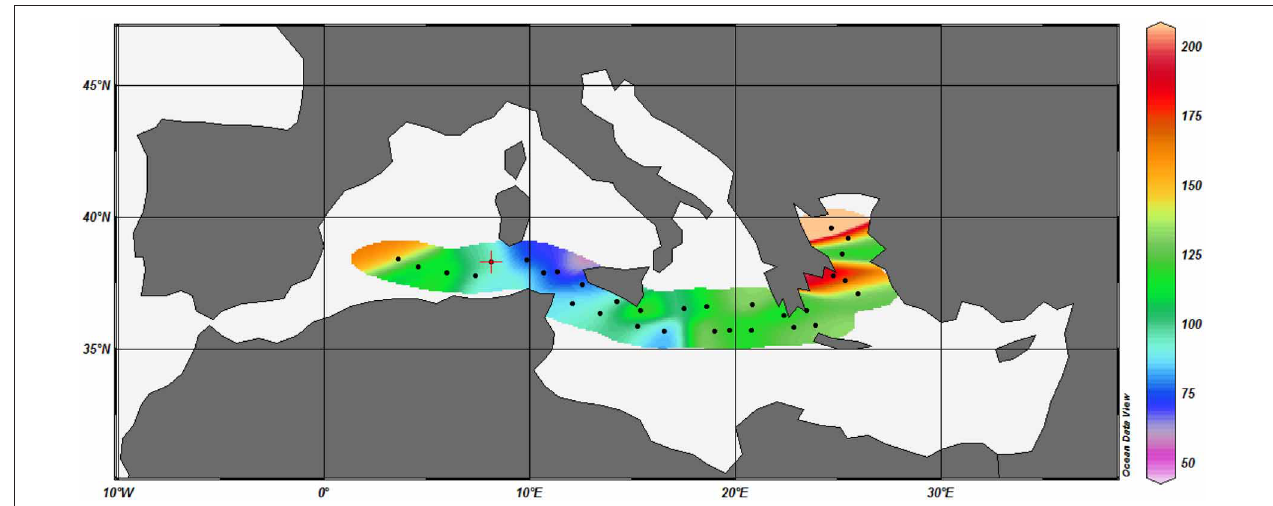
FIGURE 5 | Surface dissolved cobalt concentrations (pM) along the Mediterranean transect. Surface seawater ( < 0.22 μ m) was collected during the cruise THRESHOLDS I (from June 5 to June 30, 2006; 35.6–41.9 ◦ N,